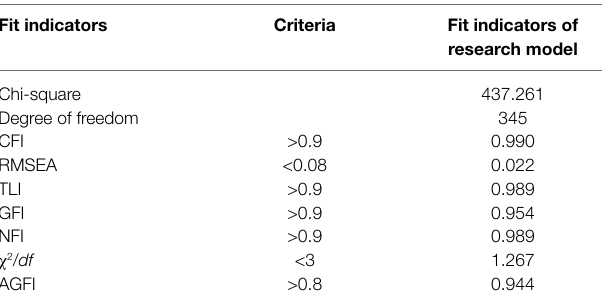
TABLE 6 | Model fit verification.